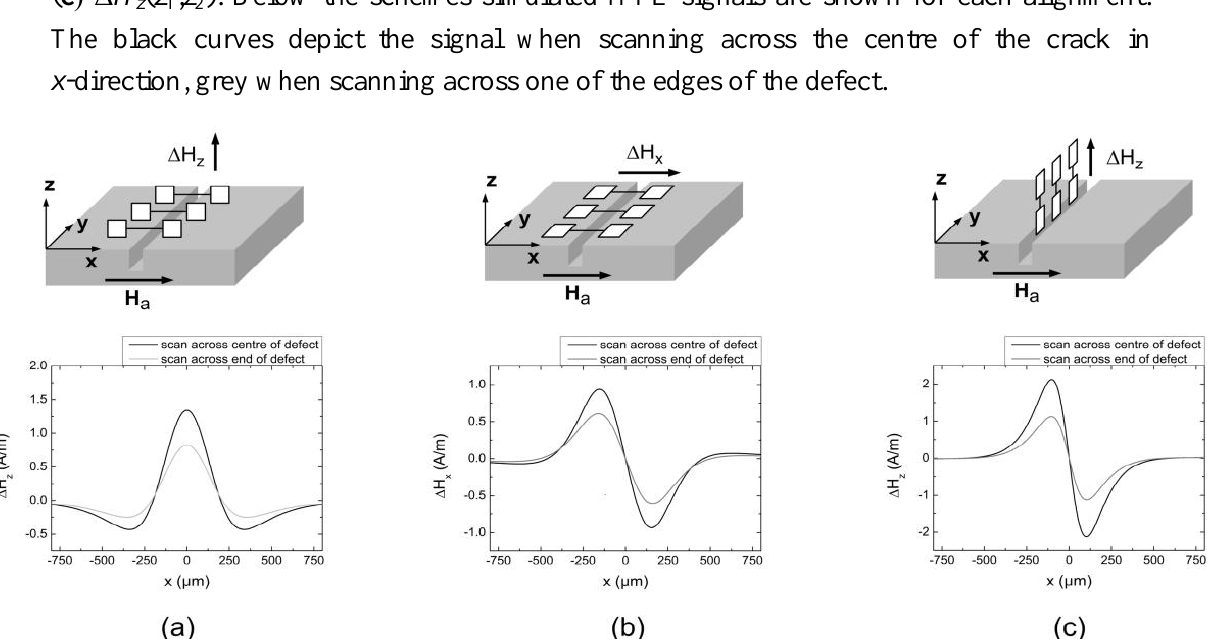
( x , x ) ( b ) Δ H ( x , x ) and z 1 2 x 1 2